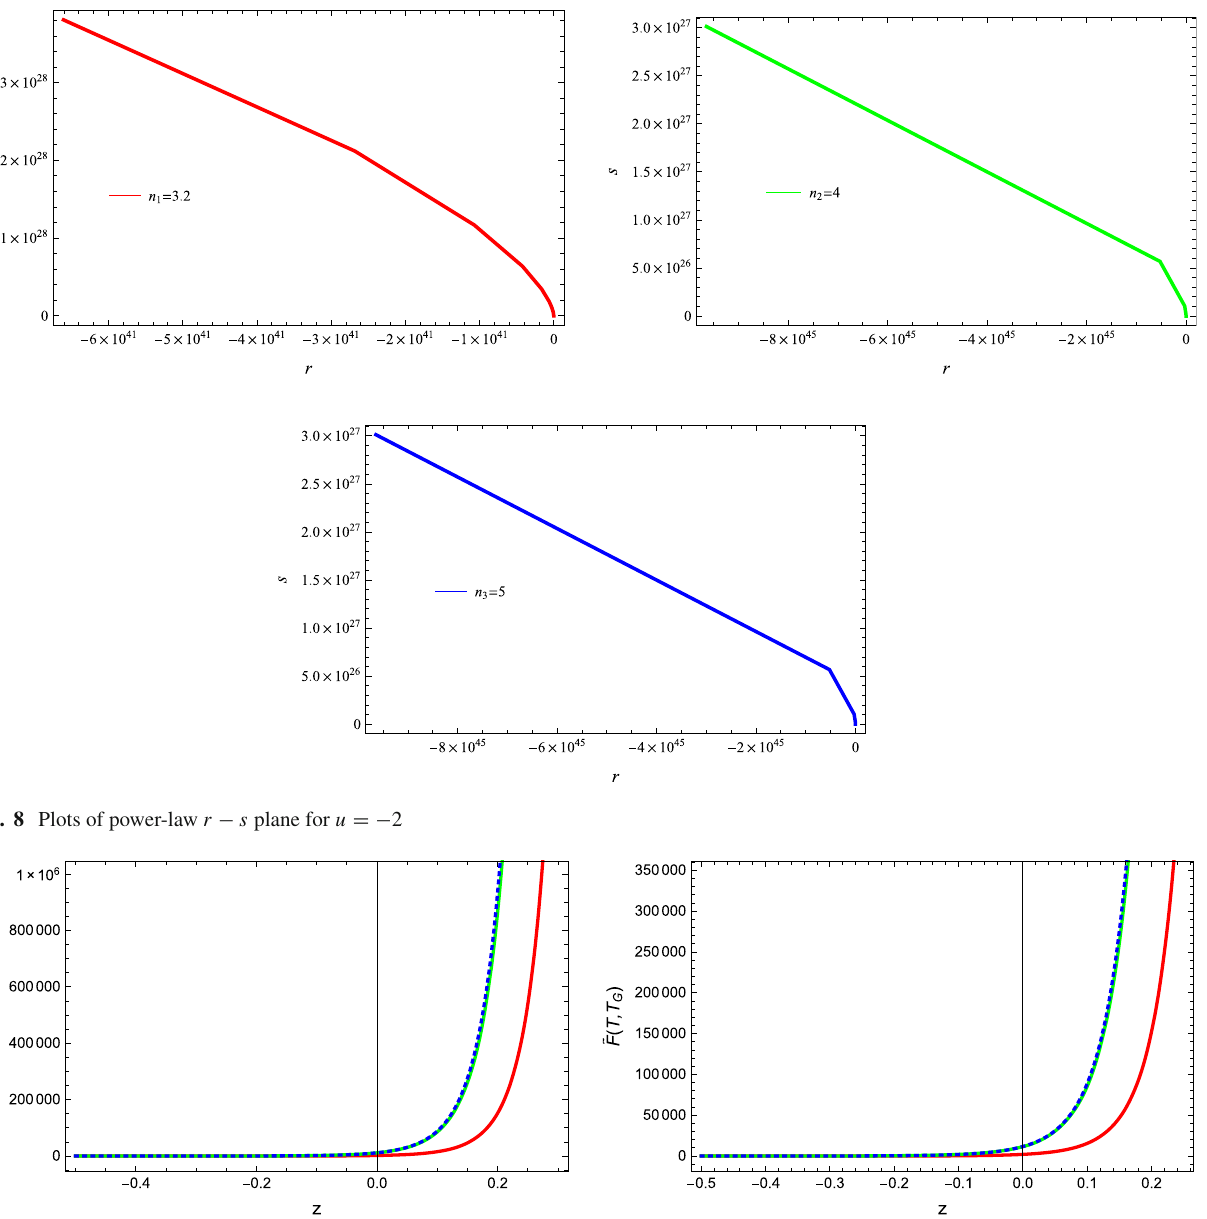
Fig. 9 Plots of unified phases reconstructed GGPDE ˜ F ( T , T G ) model for u = 2 (left) and − 2 (right). Also, H 2 = 2 . 7 (red), H 2 = 2 . 75 (green) and H 2 = 2 . 8 (blue)